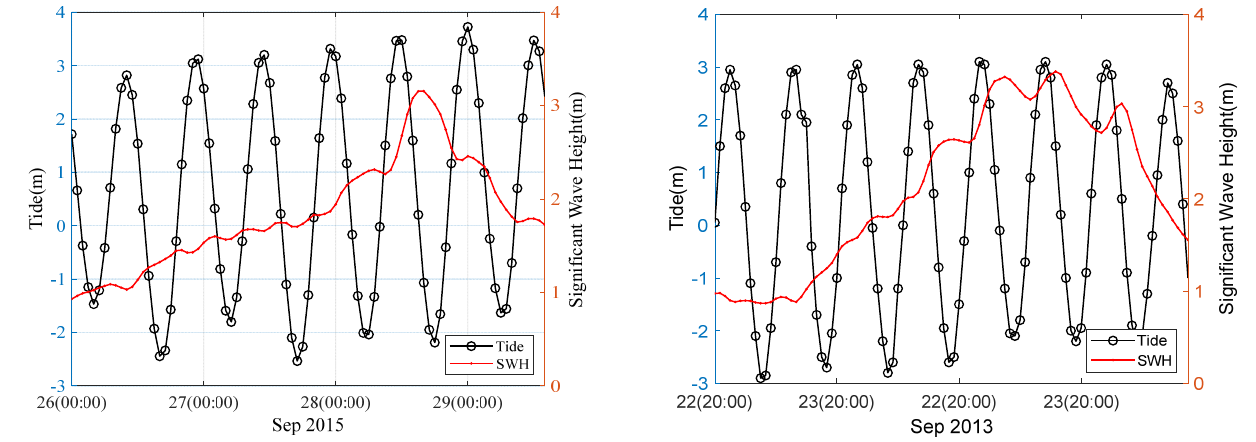
Figure 10. Water level and significant wave height (SWH) simulations at Dazuo Seawall during typhoons Usagi ( left ) and Dujuan ( right ). Eight sets of experiments are conducted according to the simulation of wave heights and tide levels three days before the landfall of both typhoons. As shown in Tables 2 and 3, Exp 1 stands for the conditions at the time of the largest significant wave; Exp 2